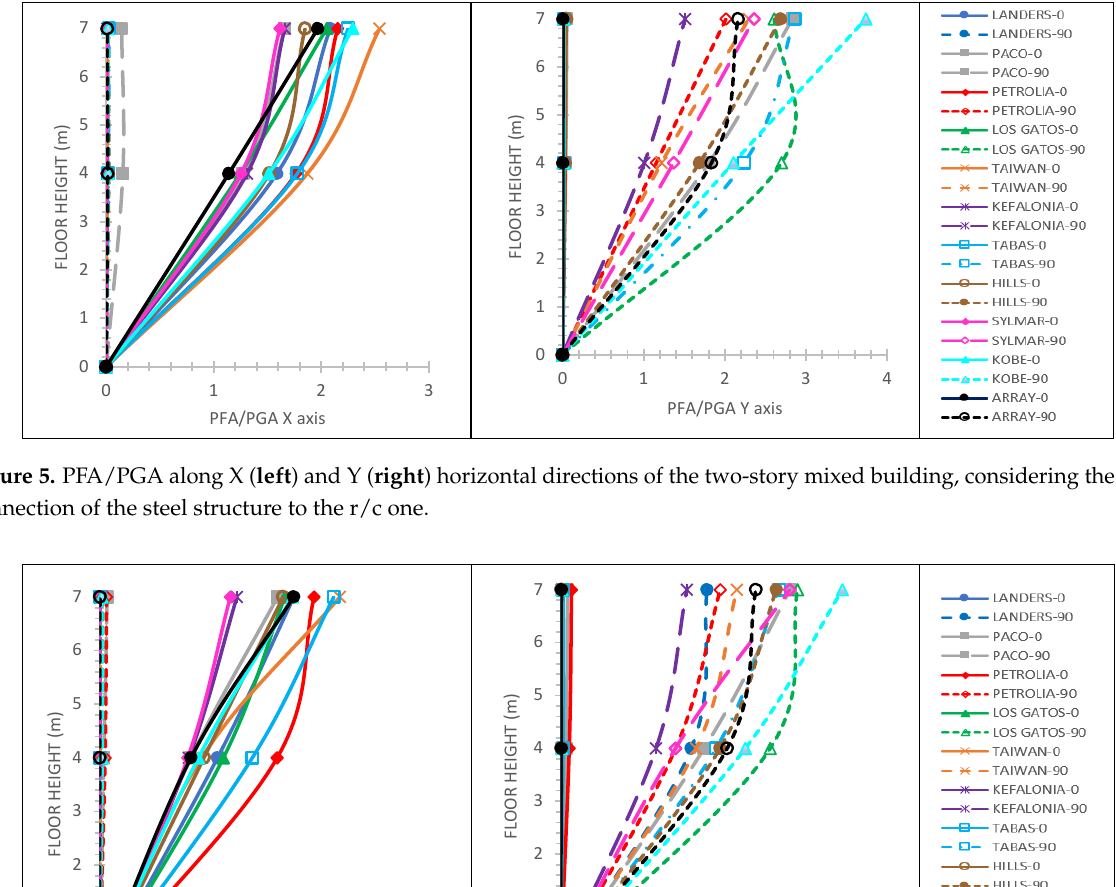
Figure 4. RIDR along X (left ) and Y ( right ) horizontal directions of the two-story mixed building, considering the fixed- pinned connection of the steel structure to the r/c one.